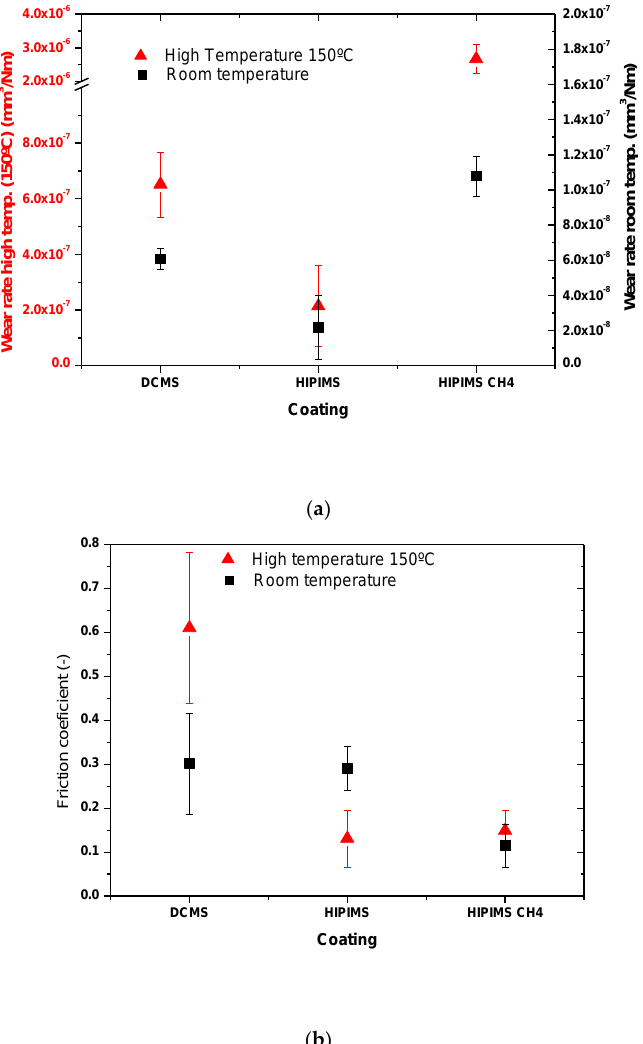
Figure 6. Specific wear rate at high (150°C) and room temperature ( a ); average friction coefficient for both temperatures ( b ).